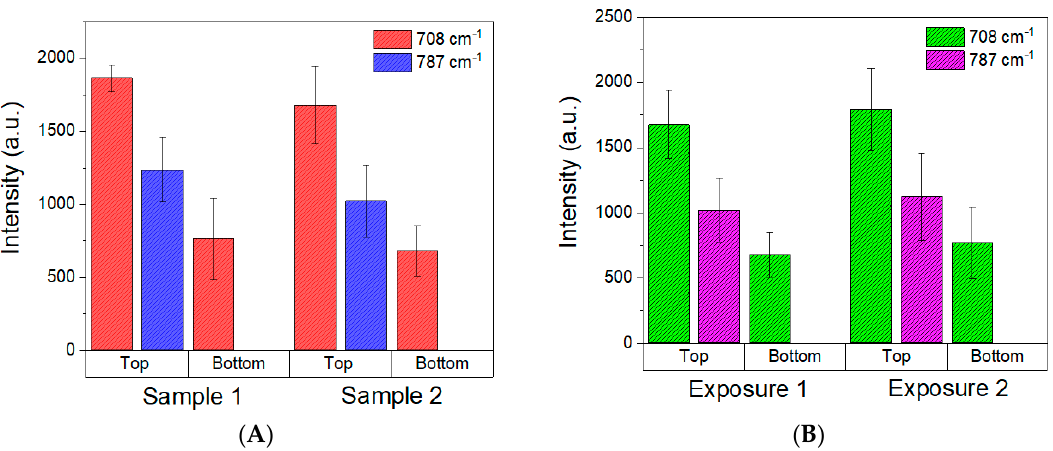
Figure 11. Column diagram represents the SERS intensity of the DMMP modes 708 and 787 cm − 1 measured ( A ) on the different 1G_Ag_AuNP upon the exposure to DMMP (1.2 ppmV) and ( B ) on the same 1G_Ag_AuNP upon the double exposure to DMMP (1.2 ppmV). The SERS intensities are the average of 6 spots at different sample position, the error bars are the intensity standard deviation.